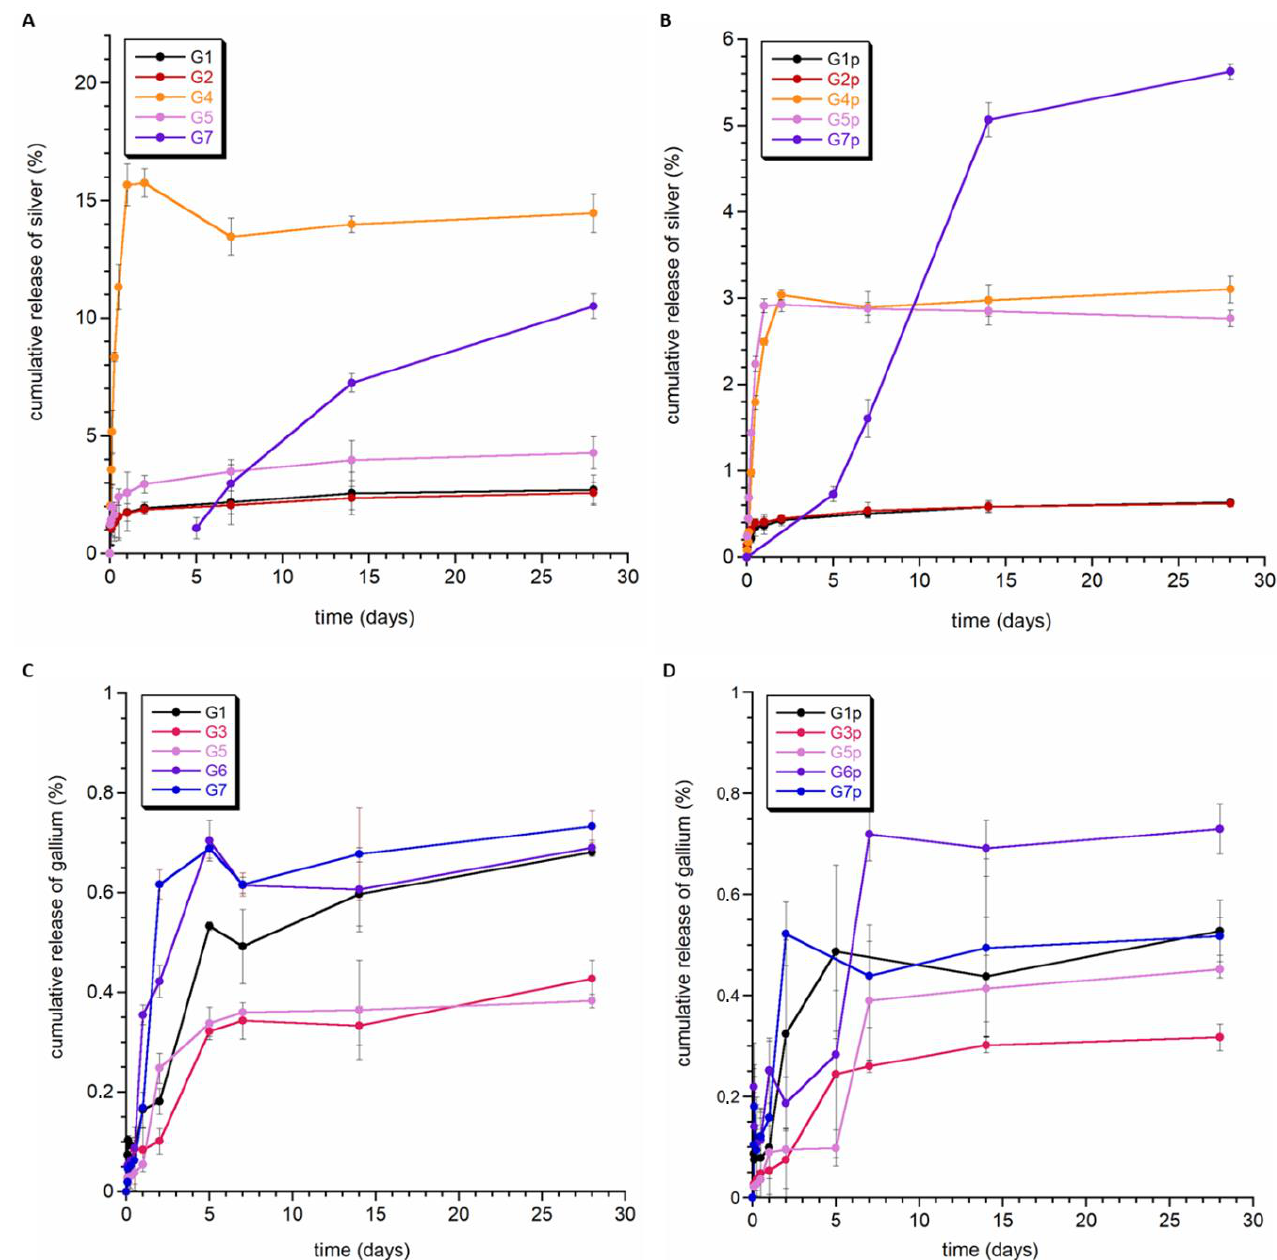
Figure 5. Release profiles of silver ( A , B ) and gallium ions ( C , D ) from the granules.